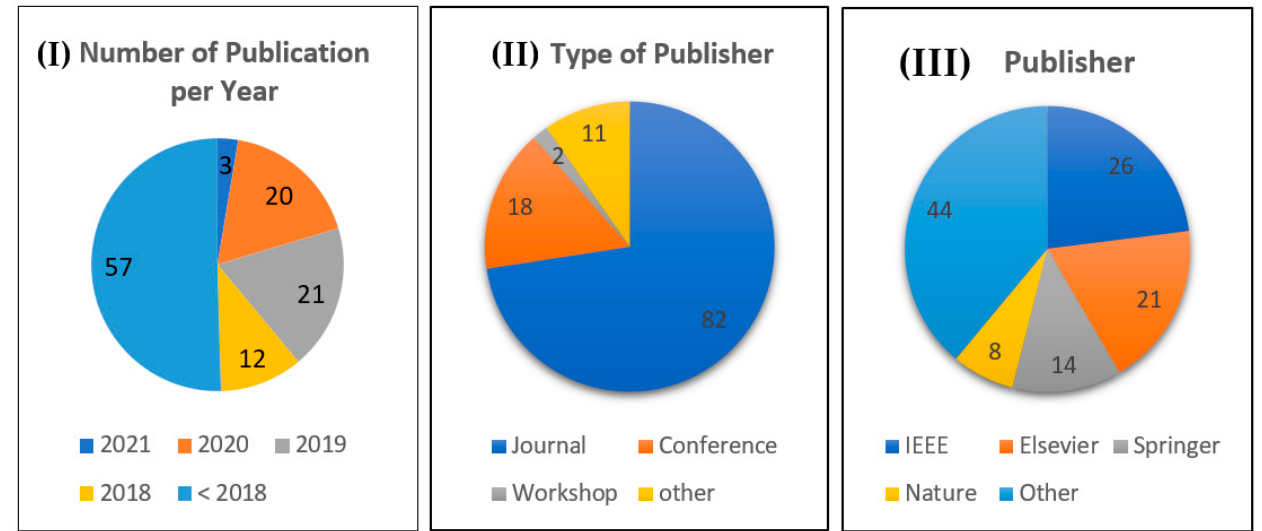
Figure 2. Statistical distribution of studies used in this survey. ( I ) Number of studies per year; ( II ) Type of Publisher, where other denotes a preprint or URL; ( III ) Publisher, where other includes MDPI, Frontiers, AVES, etc.